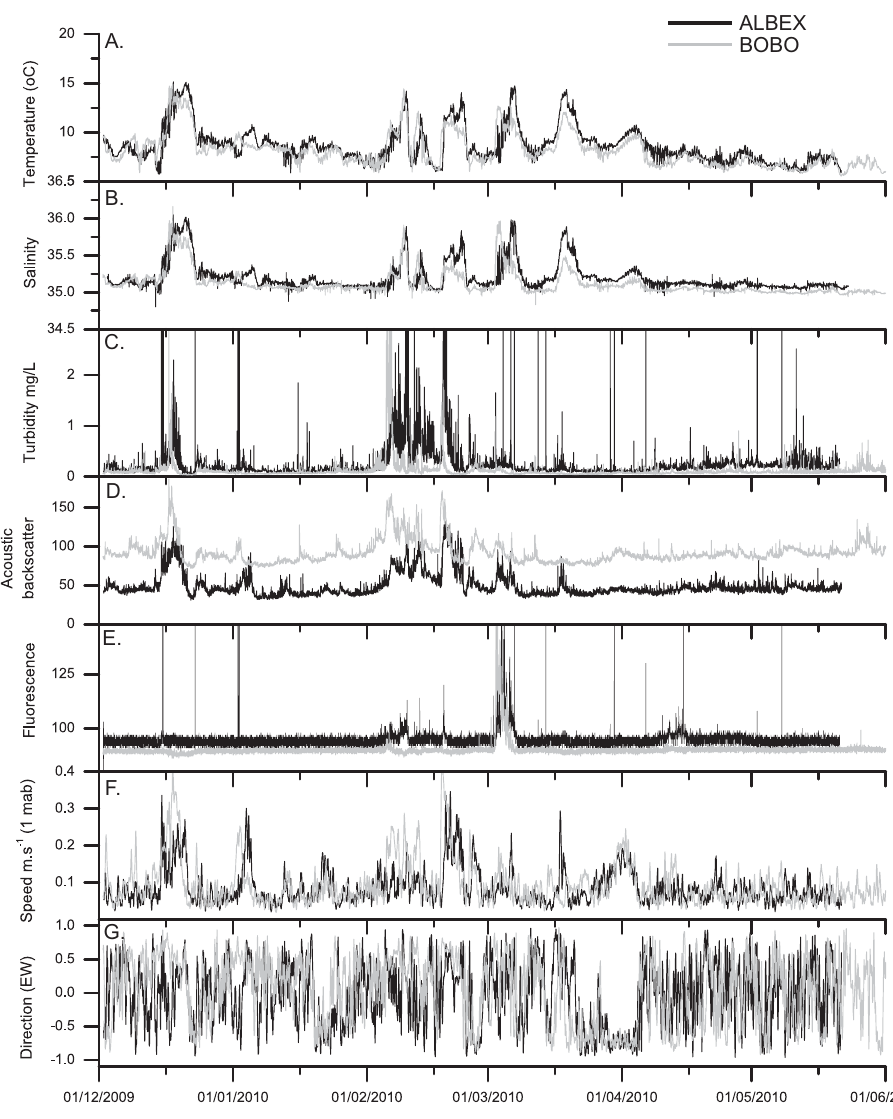
Fig. 9. Six-month records (December 2009–May 2010) from instruments mounted on ALBEX and BOBO benthic landers. (A) Temperature, (B) salinity, (C) turbidity calculated from optical backscatter, (D) acoustic backscatter, (E) fluorescence in relative units, (F) current speed at ALBEX deployment site at height of 2m (black line) and at 40m (grey line) above bottom, (G) current direction at ALBEX deployment site. In (A–E) the ALBEX data are shown as black lines, and BOBO data as grey